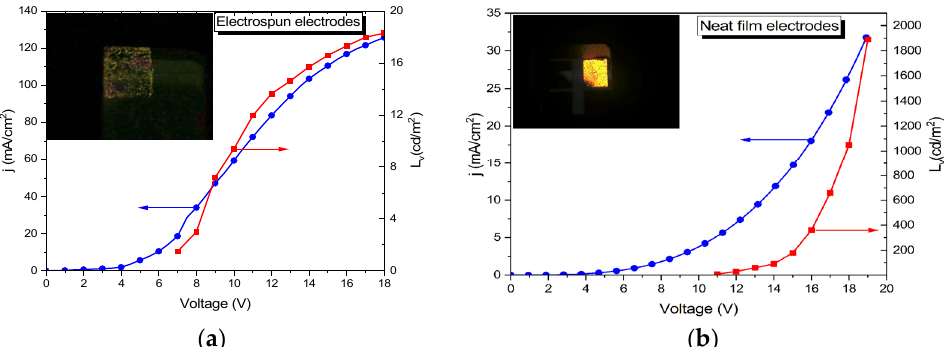
Figure 4. Luminance-current-voltage characteristics for an OLED with ( a ) an electrospun cathode; ( b ) a thin film cathode.